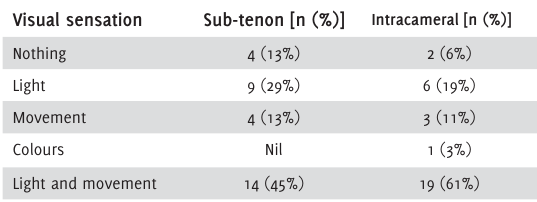
Table 2. Qualitative Description of Visual Sensation during Surgery for Both Groups.